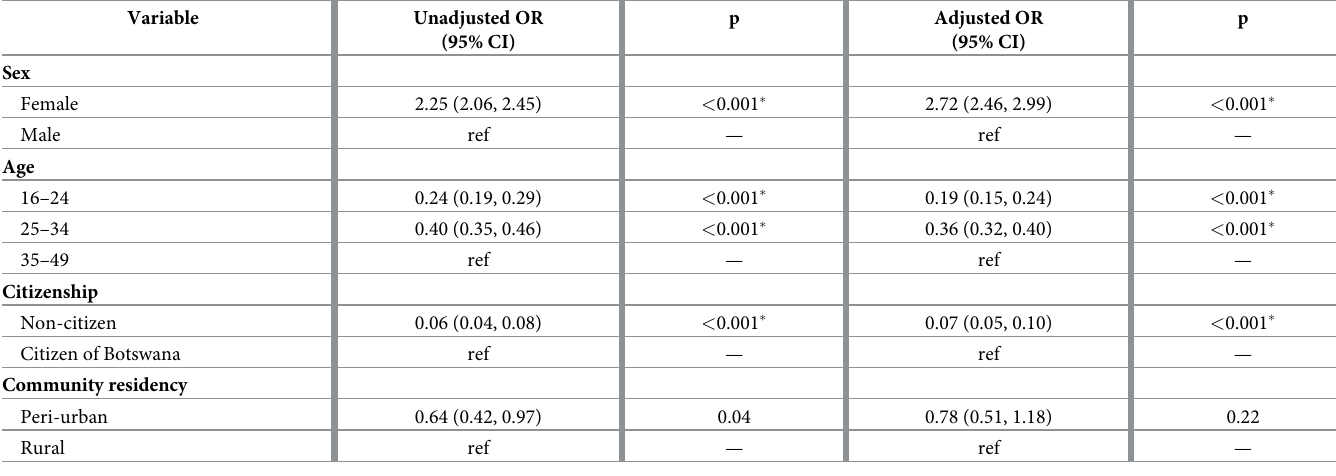
Table 4. Association of sociodemographic variables with prior knowledge of HIV-positive status among those assessed as HIV-positive, n = 11,785. Variable